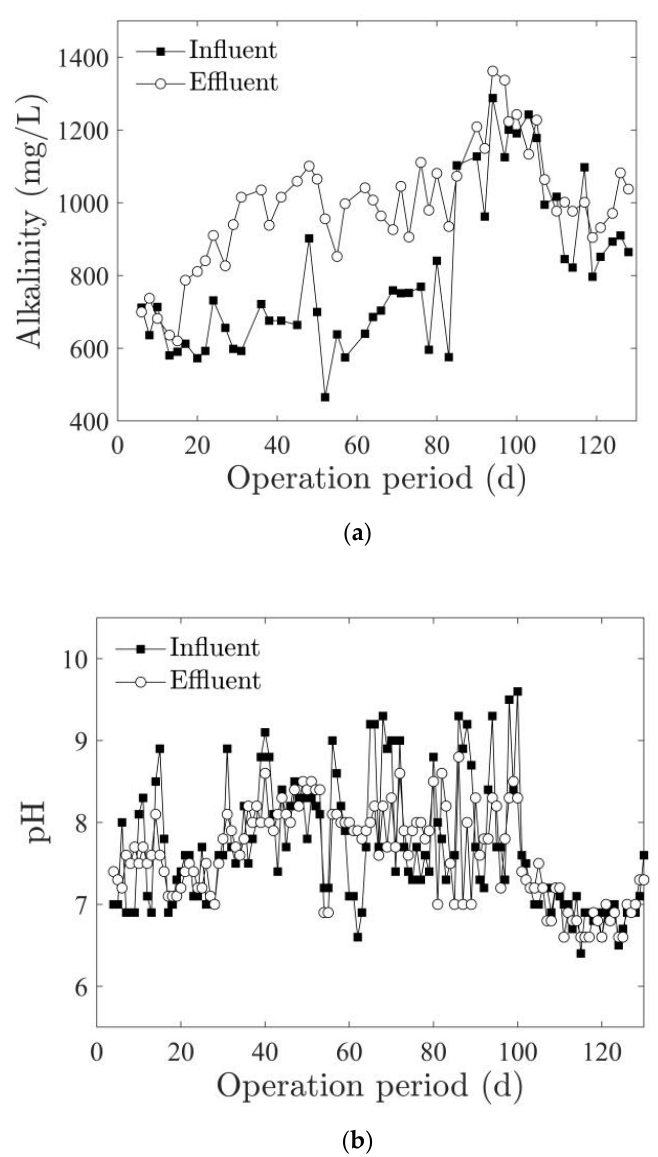
Figure 3. Variation of the alkalinity and pH of the influent and effluent wastewater during the ABR operation period. ( a ) shows the variation of alkalinity in the influent, Compartment 3 and effluent; ( b ) shows the variation of alkalinity in the influent and effluent.